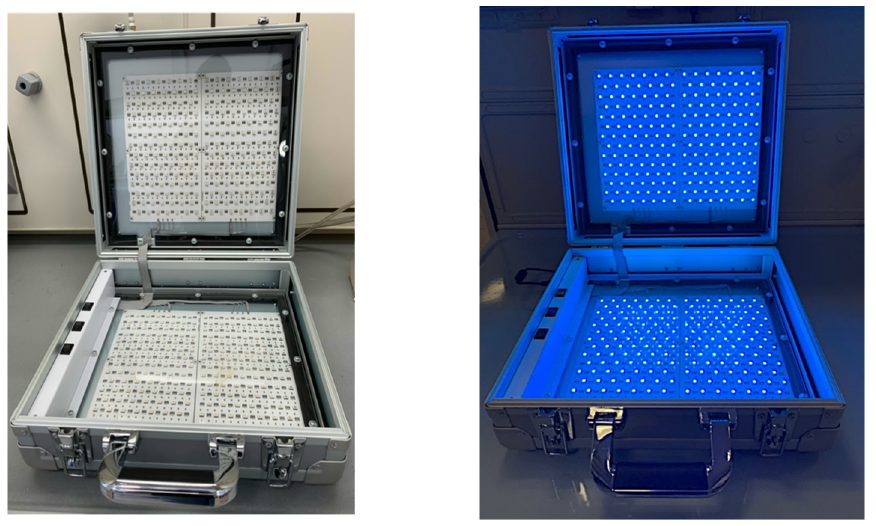
Figure 7. Protype instrument for light exposures.